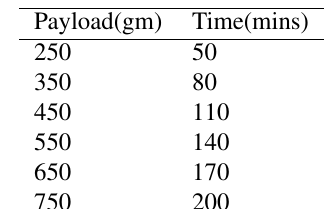
Table 1. Payload associated with Time